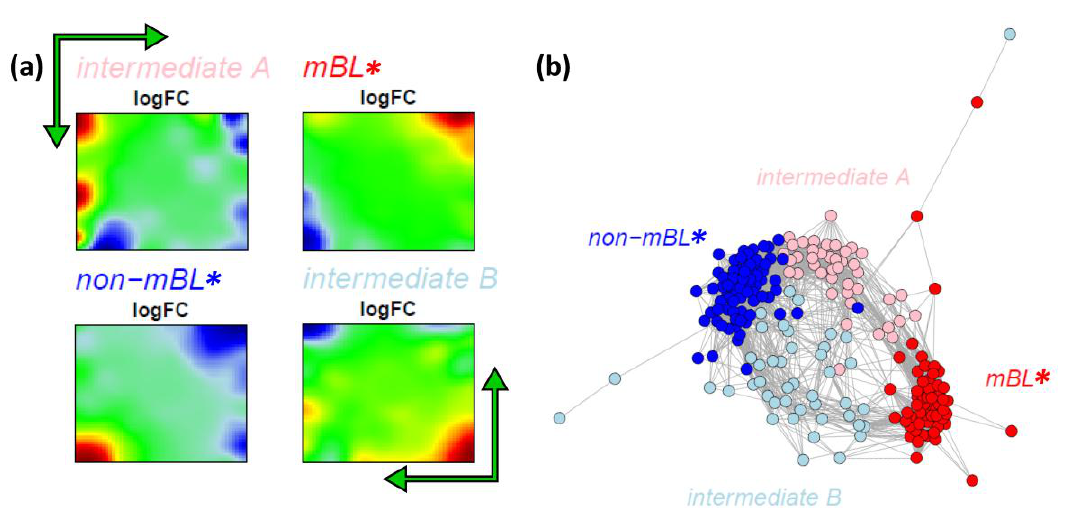
Figure 7. k-Means clustering into four subtypes: ( a ) Mean expression portraits of the four new subtypes. The green arrows indicate the spot pattern transitions from mBL to non-mBL via intermediate A or B. ( b ) CN colored according to the new subtypes